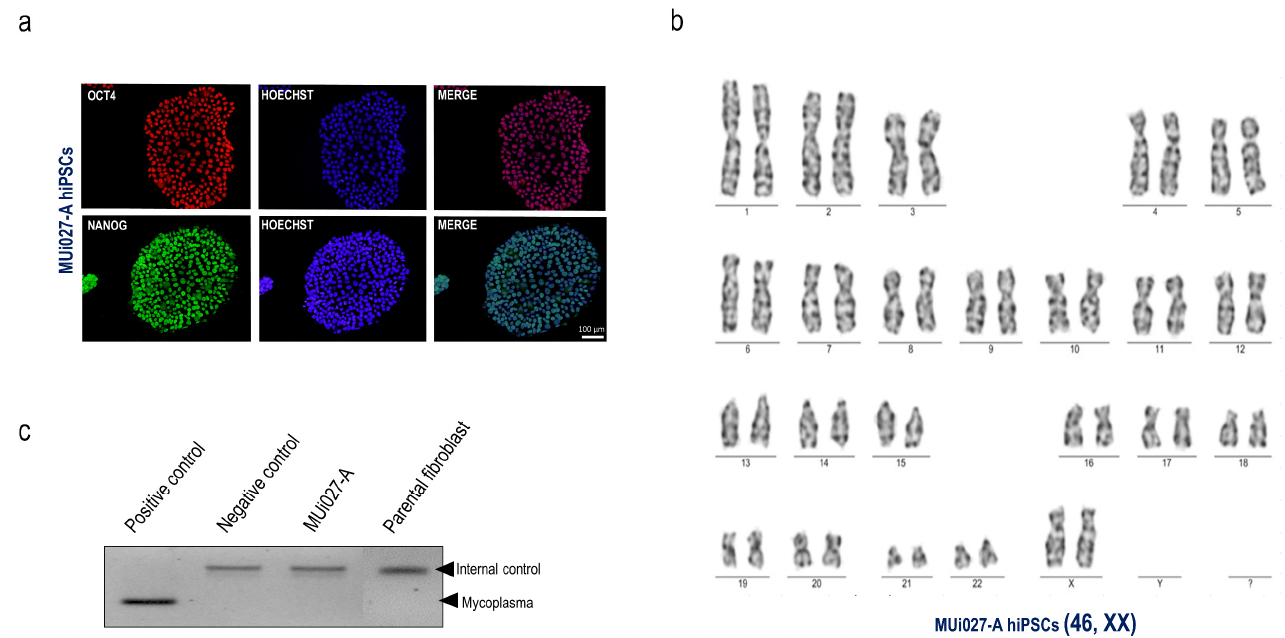
Figure 2. Characterization of human iPSC line MUi027-A. ( a ) Immunostaining of MUi027-A hiPSCs with OCT-4, and NANOG. Scale bars: 100 µ m. ( b ) Karyotyping of MUi027-A iPSCs. ( c ) PCR gel electrophoresis results for detection of mycoplasma contamination in MUi027-A iPSCs, including parental fibroblasts.